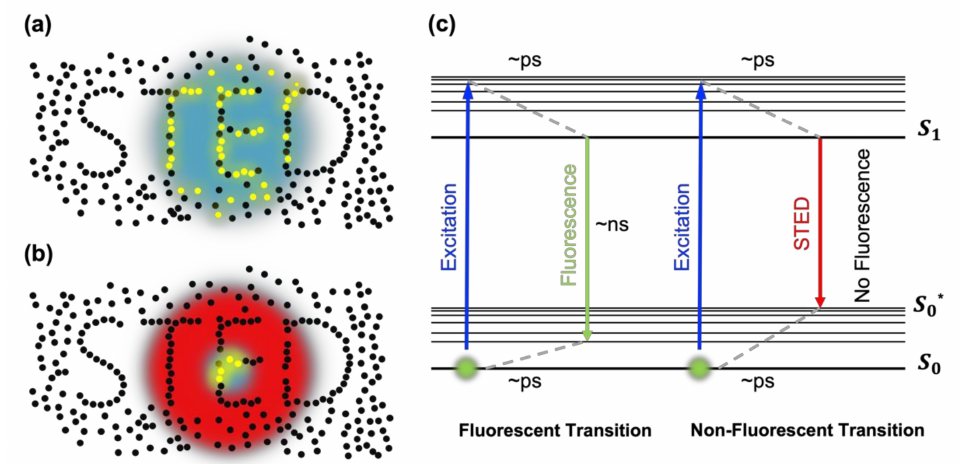
Figure 1. Basic working principle of STED nanoscopy. ( a ) Focal spot of conventional confocal microscopy. Fluorophores in the PSF of the excitation laser undergo fluorescent transitions. ( b ) Focal spot of the STED nanoscopy. Only fluorophores at the very center of the STED beam undergo fluorescent transitions. ( c ) Jablonski diagram of two molecular transitions: fluorescent transition (spontaneous emission) and nonfluorescent transition (stimulated